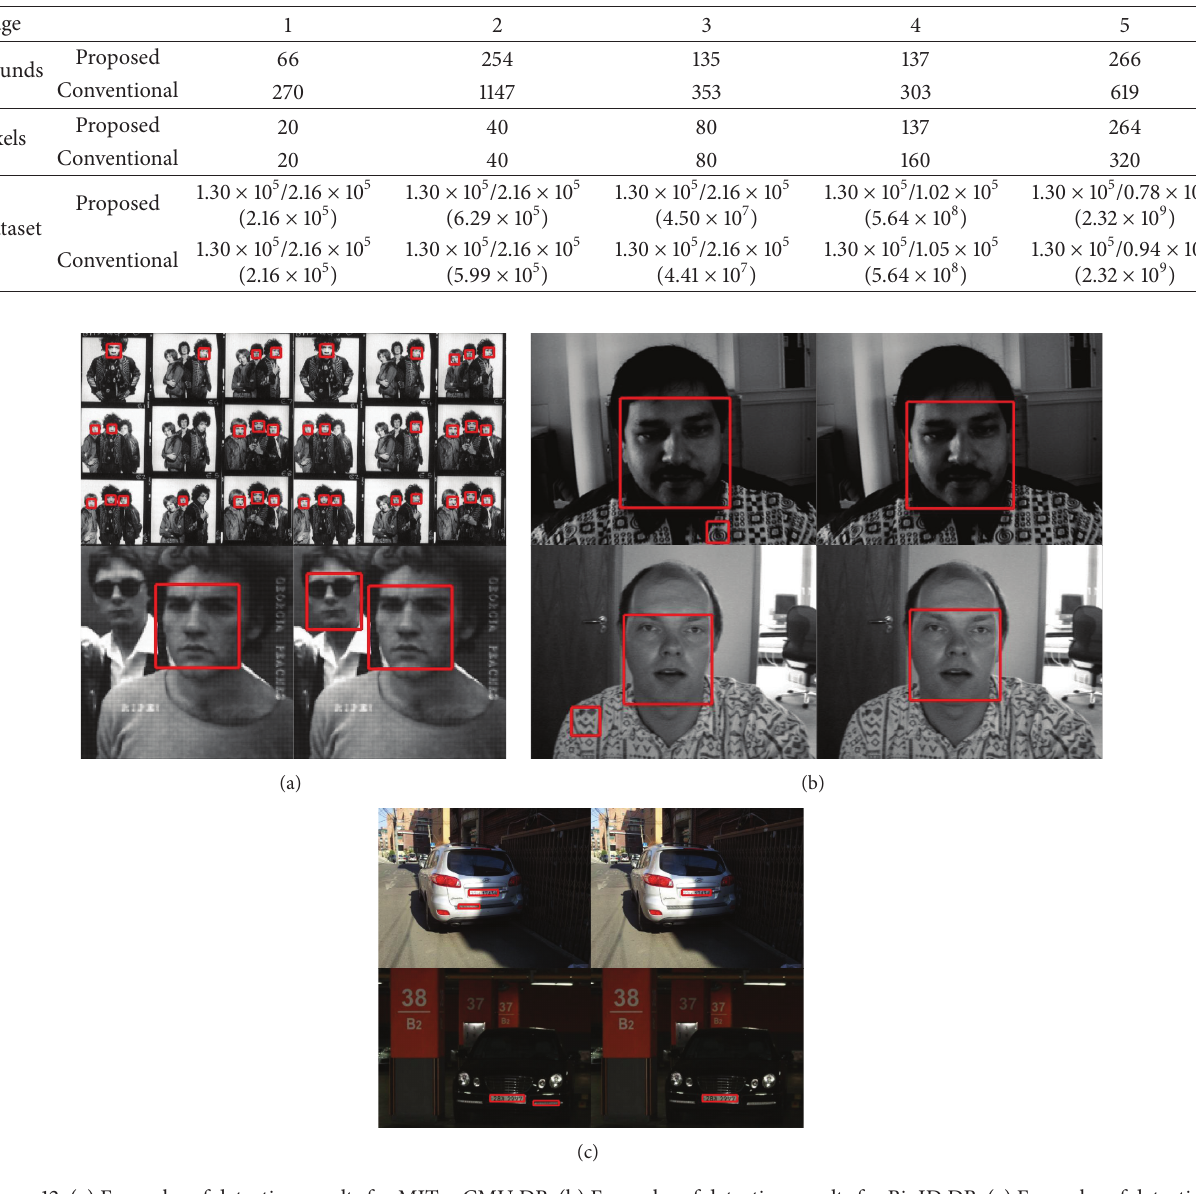
Table 3: Information of the trained classifiers for license plate detection at each of 5 stages.